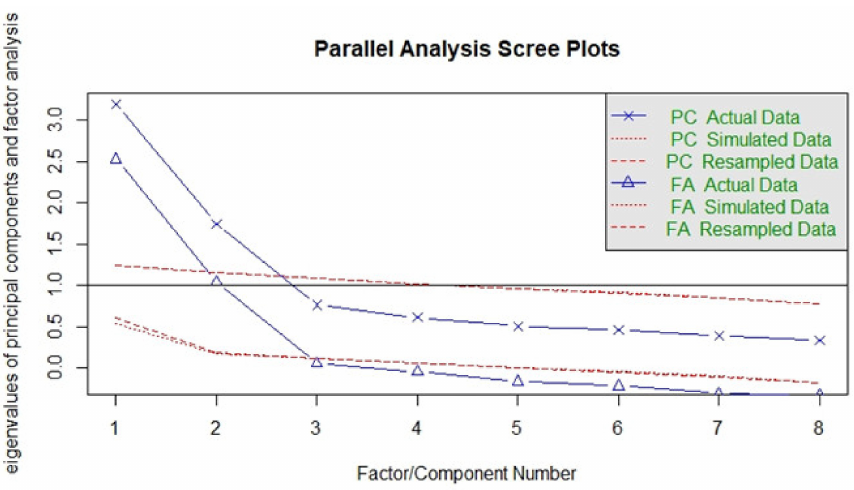
Figure 1. Parallel analysis (N = 302). Table 2. Exploratory factorial analysis of the instrument (N =